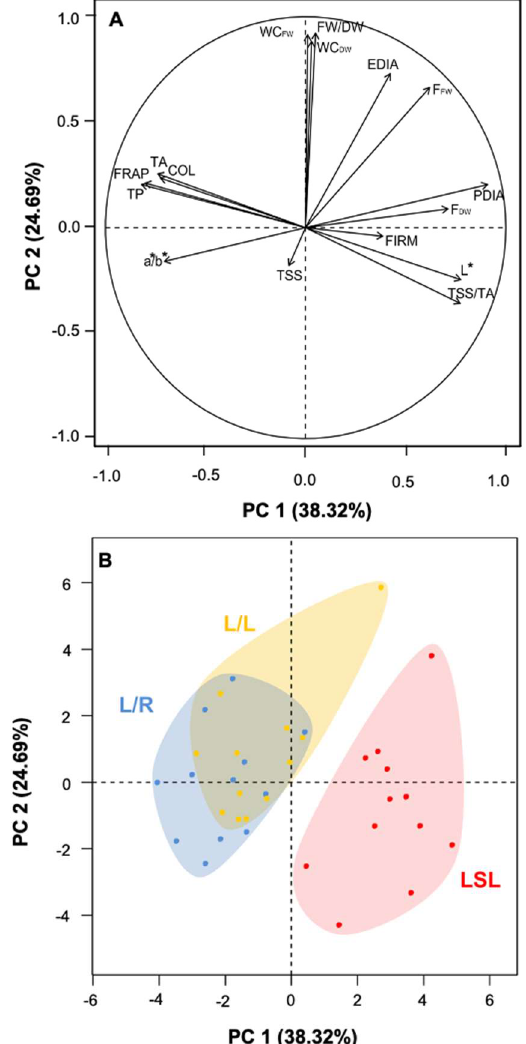
Figure 11. Principal components analysis (PCA) of the agronomic and functional fruit quality for the three treatments ( A , B ). Individual graphs showing the mean values per each replicate. Abbreviations are explained as follows: a*/b*: Fruit level of redness; COL: fruit visual color; EDIA: equatorial diameter; F DW : fruit dry weight; F FW : fruit fresh weight; FW/DW: fresh weight to dry weight ratio; FRAP: ferric-reducing antioxidant power of the fruit; FIRM: pulp firmness; L*: fruit spectral color parameters; PDIA: polar diameter; TA: titratable acidity of the fruit; TP: total phenolic compounds of the fruit; TSS: total soluble solids of the fruit; TSS/TA: sweetness to acidity ratio; WC FW : water content on a fresh weight basis; WC DW : water content on a dry weight basis.